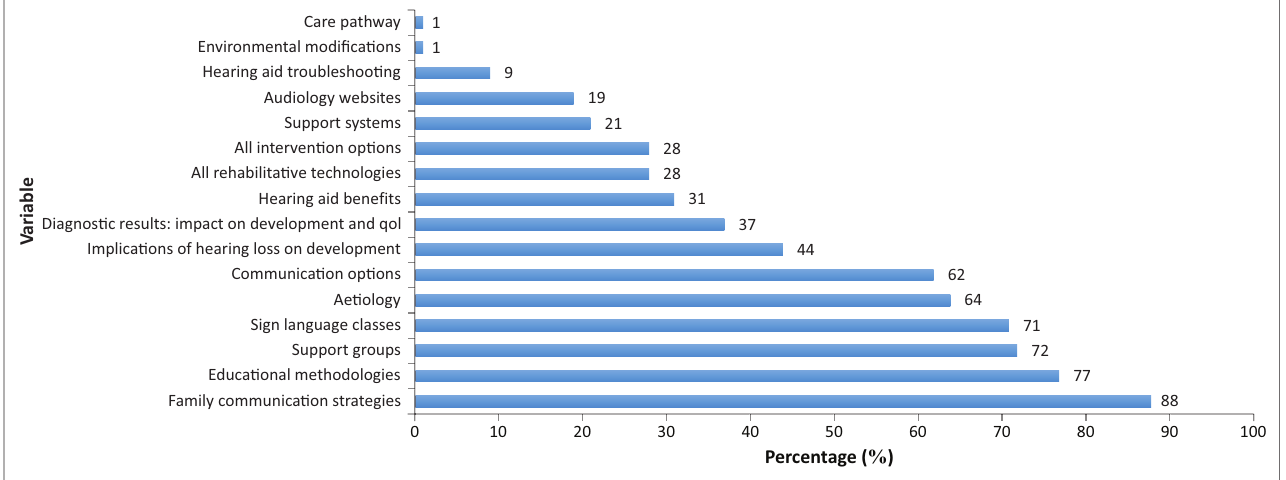
FIGURE 2: Information that parents deem critical for intervention decision-making ( N = 97).